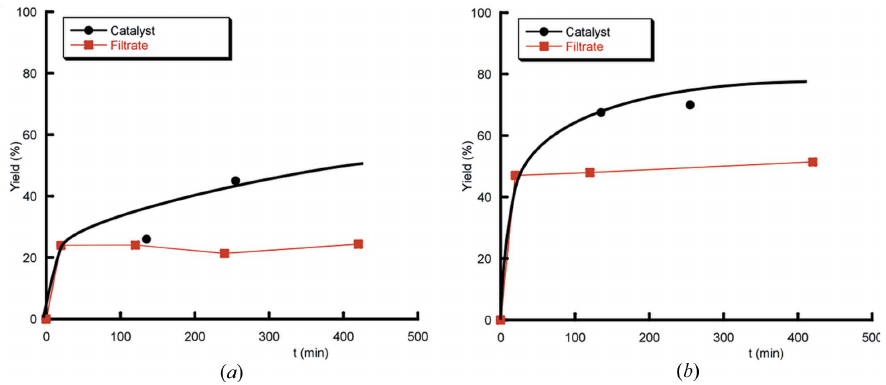
Figure 8 Kinetic profiles of the oxidation of benzyl alcohol ( a ) over compound 1 and ( b ) over compound 3 after hot filtering with TBHP.